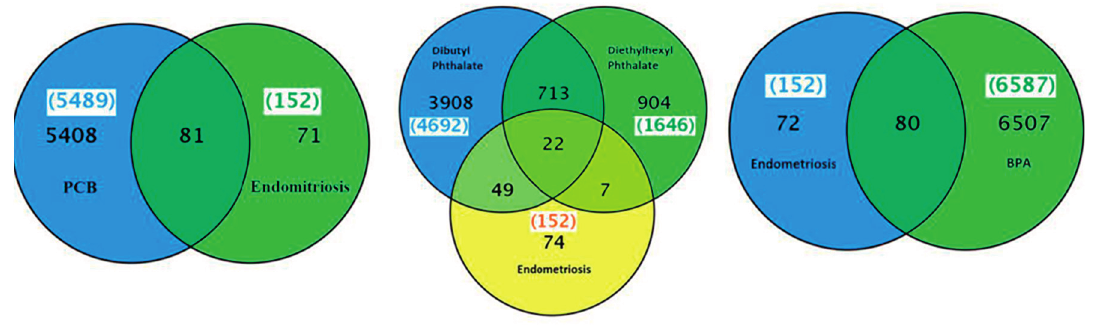
Figure 5. A Venn diagram of list of genes common between endometriosis and PCBs, phthalates or bisphenol